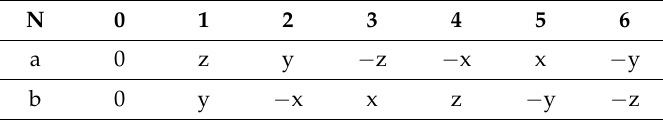
Table 1. Relation table for a, b and